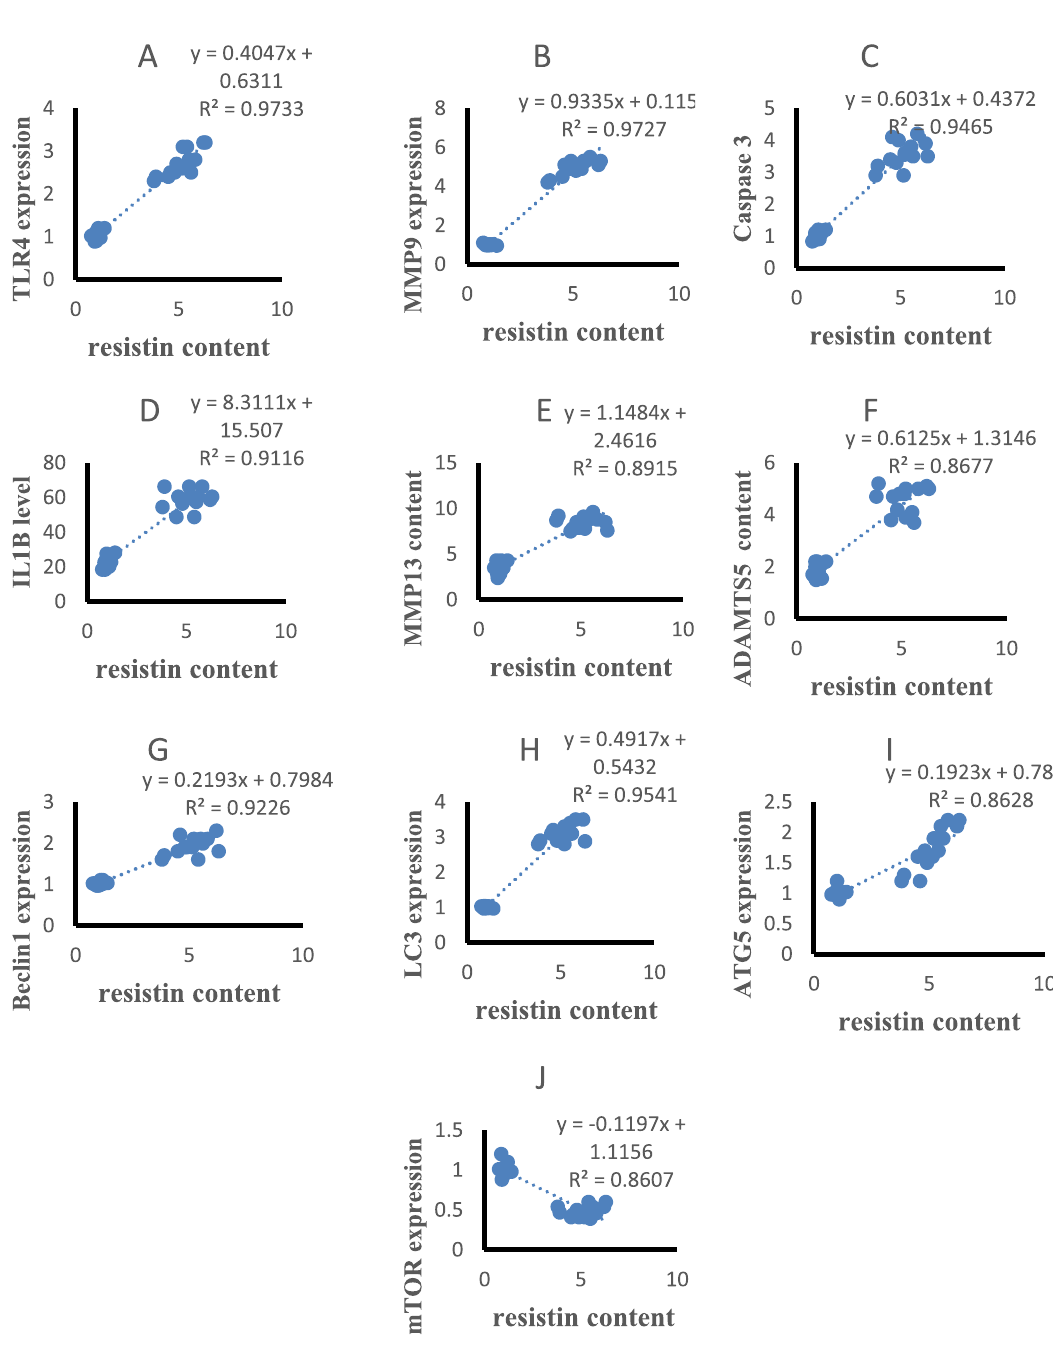
Figure 6. Correlations of cartilage resistin levels with other studied parameters in control and HFD